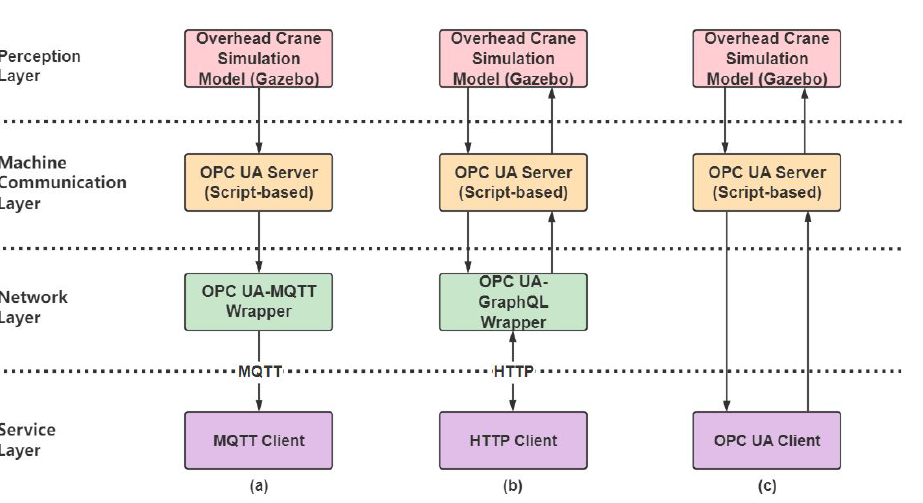
Figure 4. The architectures of three kinds of communication middleware: ( a ) OPC UA-MQTT wrapper. ( b ) OPC UA-GraphQL wrapper. ( c ) OPC UA-Unity